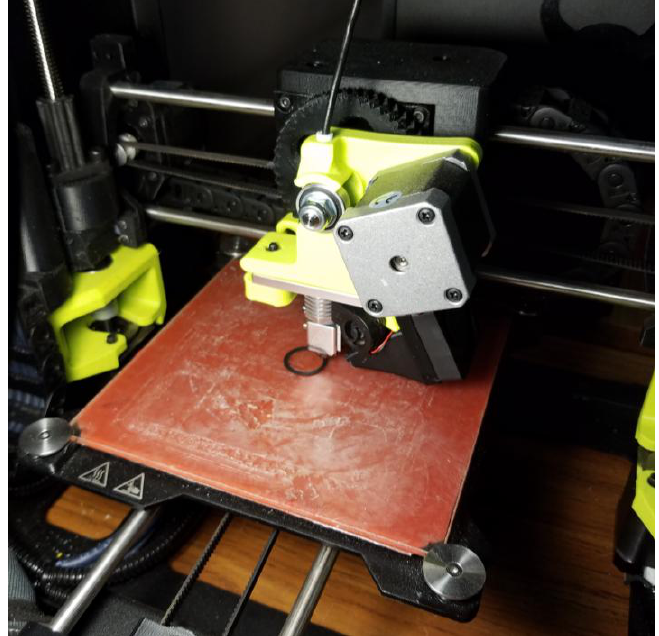
Figure 1. Lulzbot Mini with FlexyStruder upgrade mid-print with recycled thermoplastic elastomer